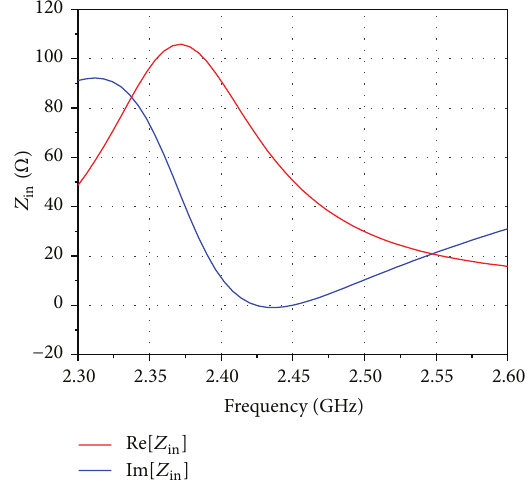
Figure 6: Input impedance of the CBHM antenna.